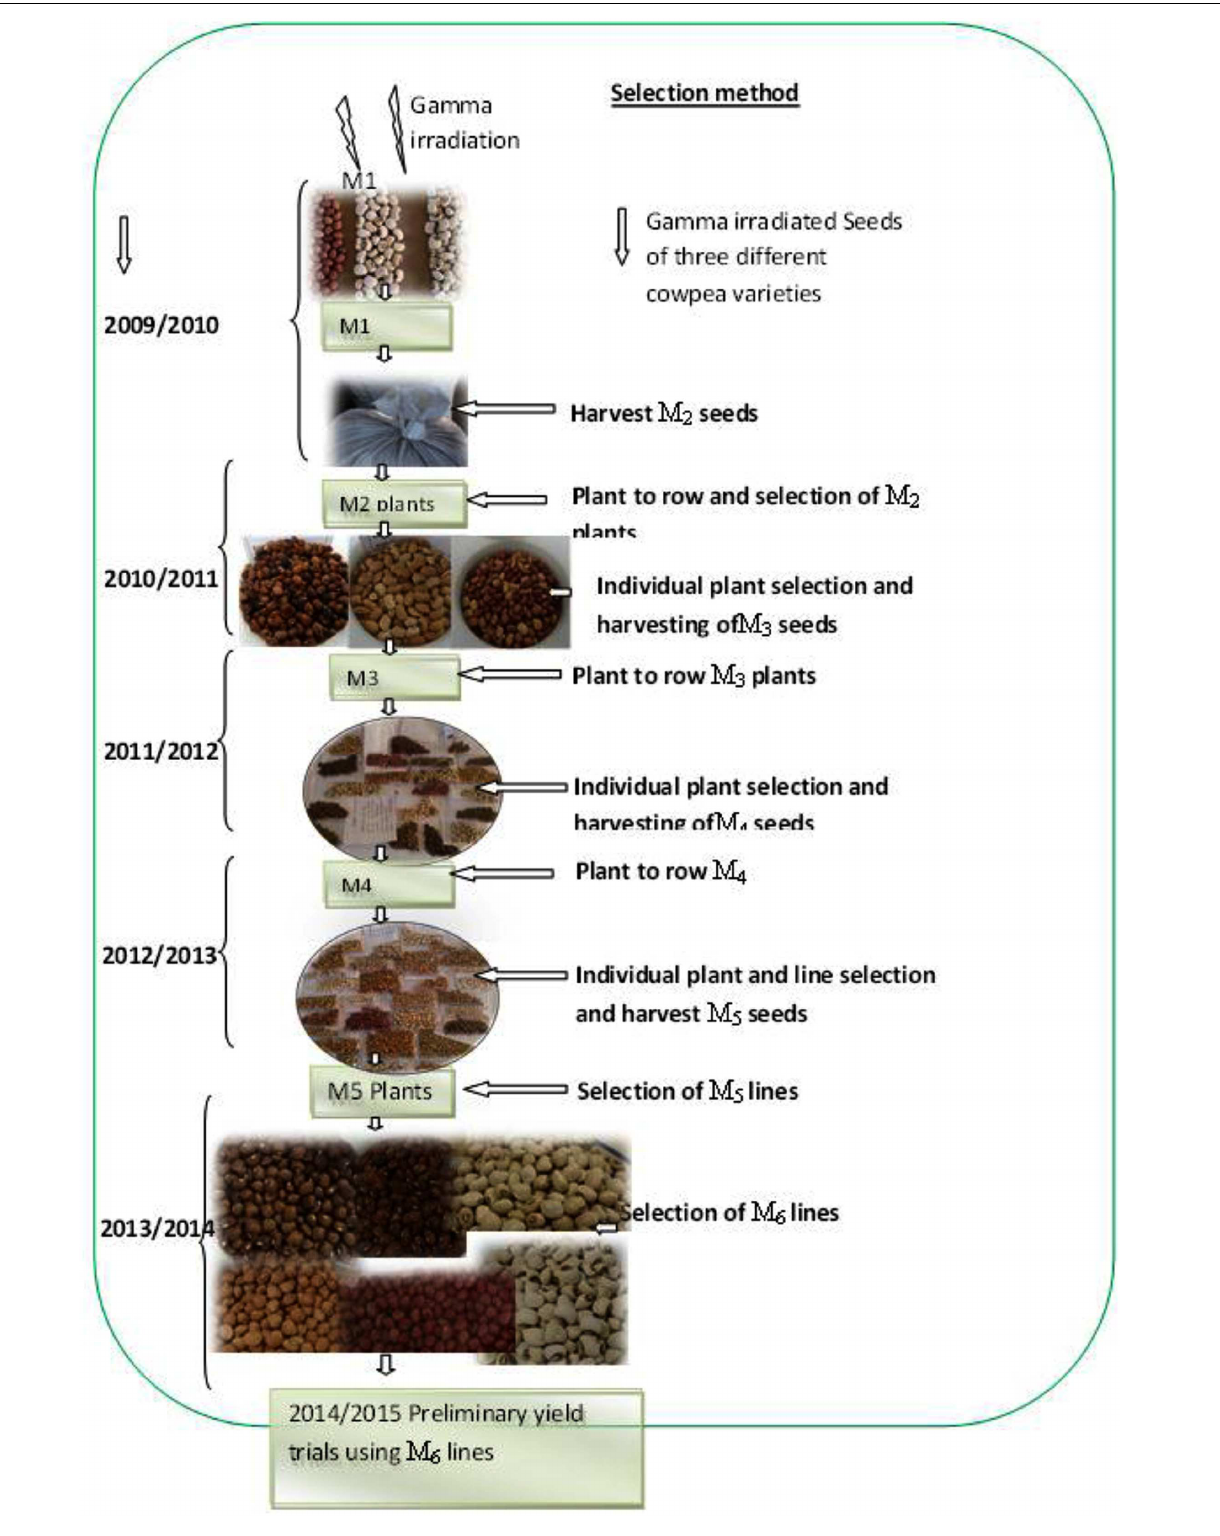
Frontiers in Plant Science |